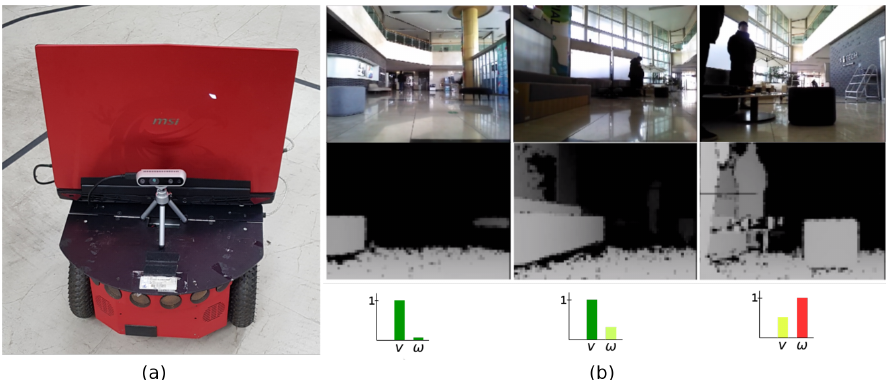
Figure 6. ( a ) Robot setup for experiments in a real environment. ( b ) Example of network outputs in a real environment. An RGB image is shown for visualization purposes, and the proposed network uses only provided depth images. v represents the linear and ω angular velocities, respectively. One represents the maximal possible value of the respective